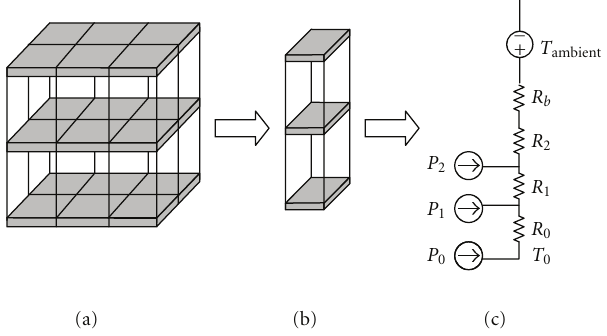
Figure 2: (a) A 3 × 2 array of tile stacks. (b) A tile stack. (c) Thermal resistance model of a tile